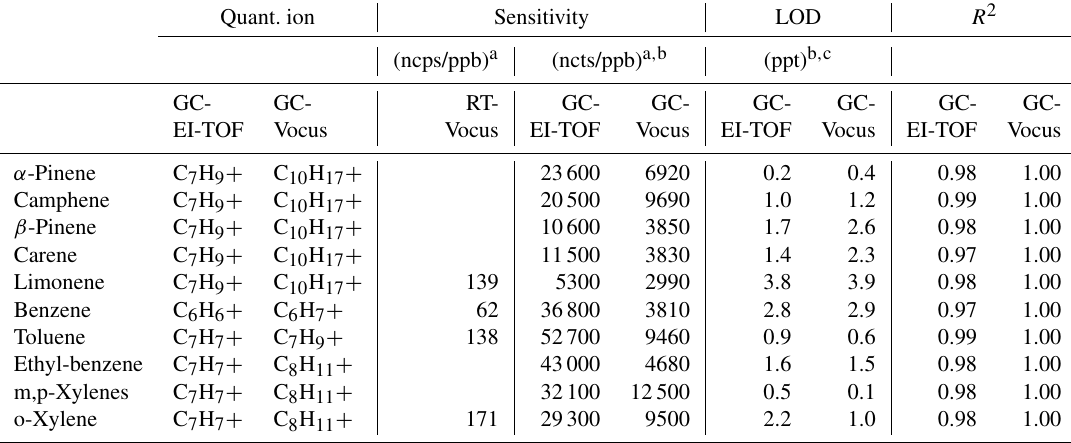
Table 1. Quantification ions, measured sensitivities (normalized counts per ppb; ncts/ppb), limits of detection (ppt), and linearity ( R 2 ) for compounds used for calibration of both the GC-EI-TOF and GC-Vocus. RT-Vocus sensitivities (normalized counts per second per ppb; ncps/ppb) for a subset of the compounds are included for